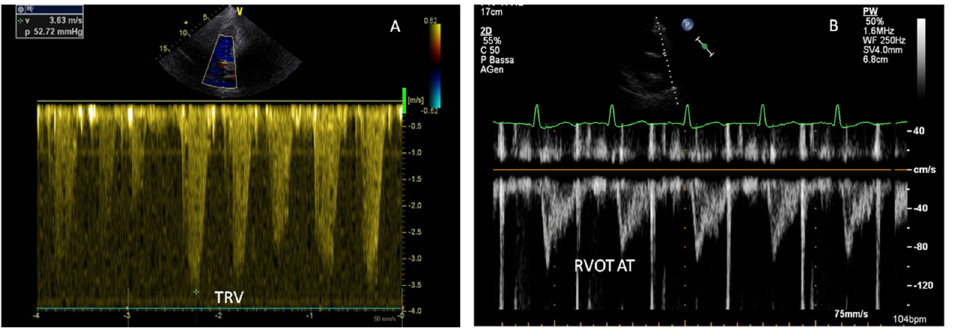
Figure 4. Echocardiographic markers of pulmonary hypertension (PH). ( A ) Increased peak tricuspid regurgitation velocity (TRV); ( B ) reduced right ventricular outflow tract (RVOT) acceleration time.